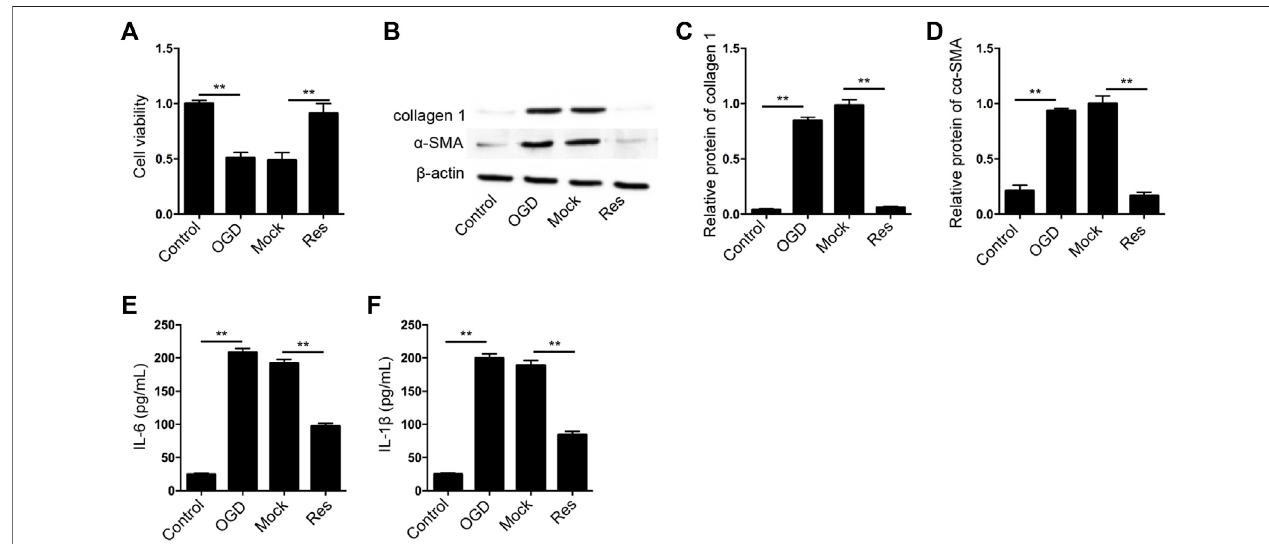
FIGURE3| ResrelievesOGD-inducedcardiomyocyteinjury. (A – F) TheOGD-treatedH9c2cellsweretreatedwithRes. (A) ThecellviabilitywasmeasuredbyCCK- 8assay. (B – D) Theexpressionofcollagen1and α -SMAwastestedbyWesternblotanalysisandwasnormalizedontheexpressionof β -actin. (E,F) ThelevelsofIL-6and IL-1 β were detected by ELISA. Data are presented as mean ± SD. Statistic signi fi cant differences were indicated: ** p < 0.01.